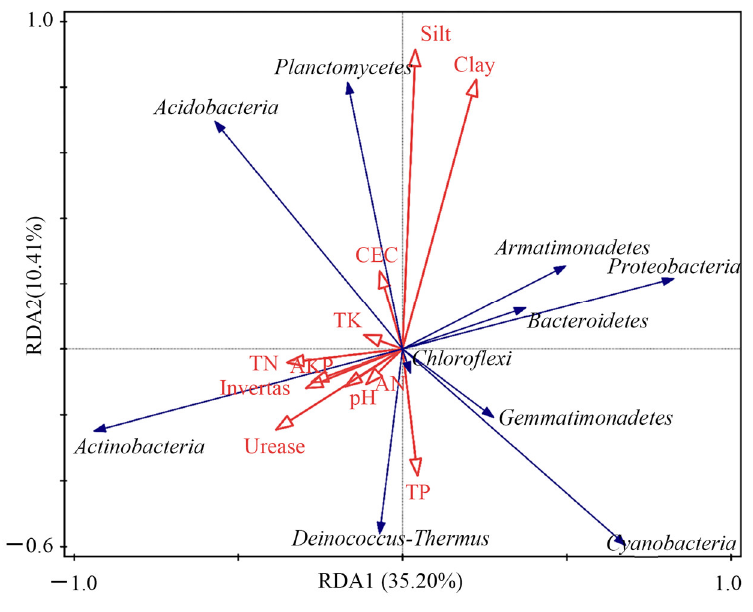
Figure 8. RDA analysis of environmental factors and major bacteria in the Heidaigou open-pit coal mine dump and control area. Note: AKP, soil alkaline phosphatase activity; CEC, soil cation ex- change capacity; pH, soil pH; TK, soil total potassium; TN, soil total nitrogen; TP, soil total phos- phorus; and WC, soil water content.